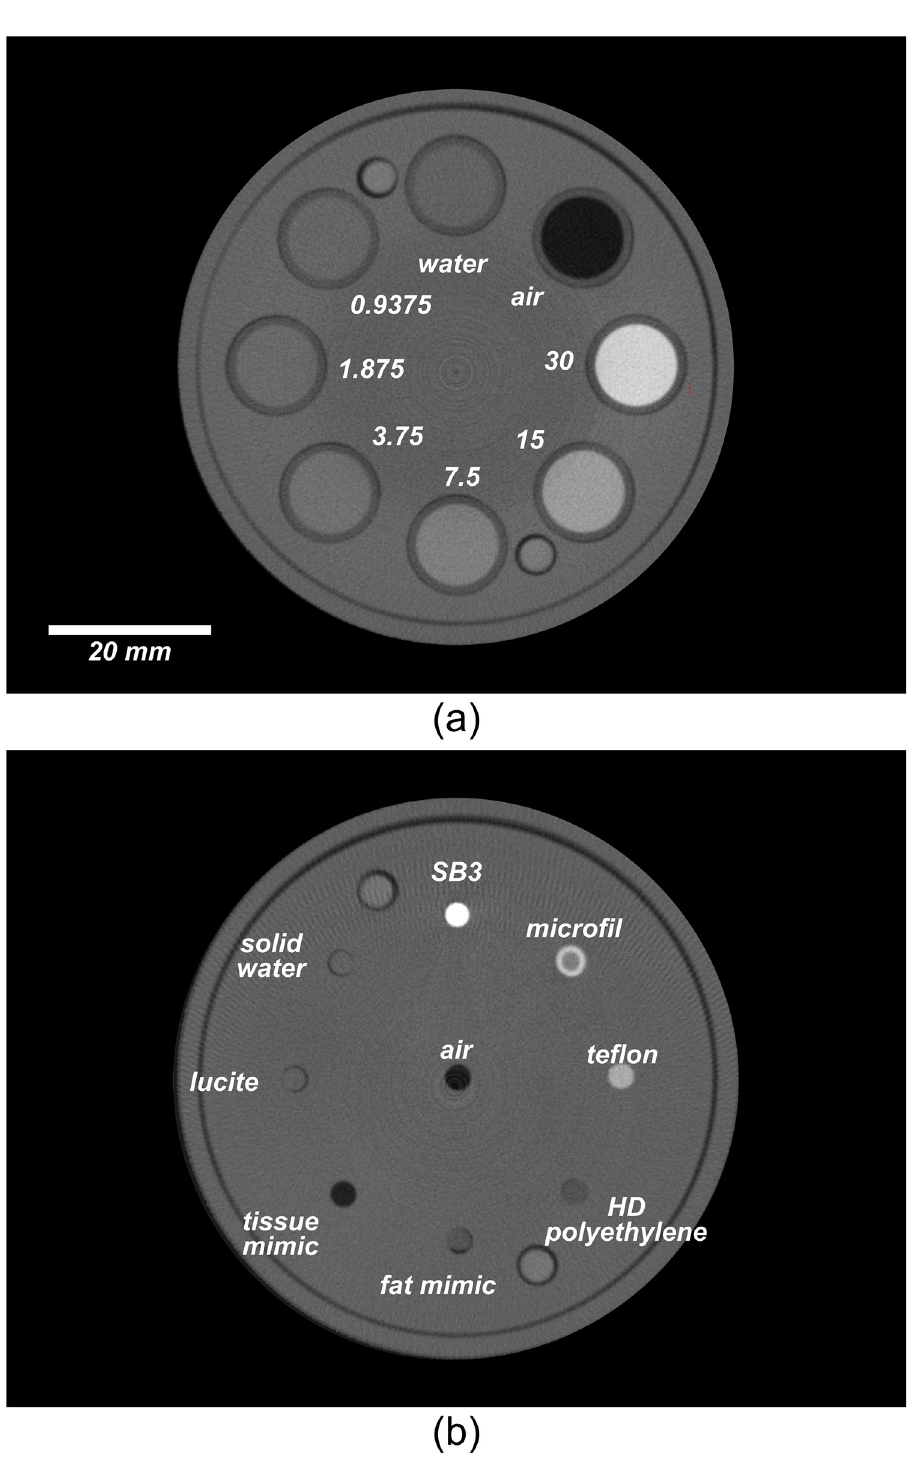
Fig 12. Reconstructed transaxial-slice CT images of the linearity plate (a) with air, water, and various concentrations of iodine shown in mg ml -1 ; and the CT number evaluation plate (b) of the CT quality assurance phantom.